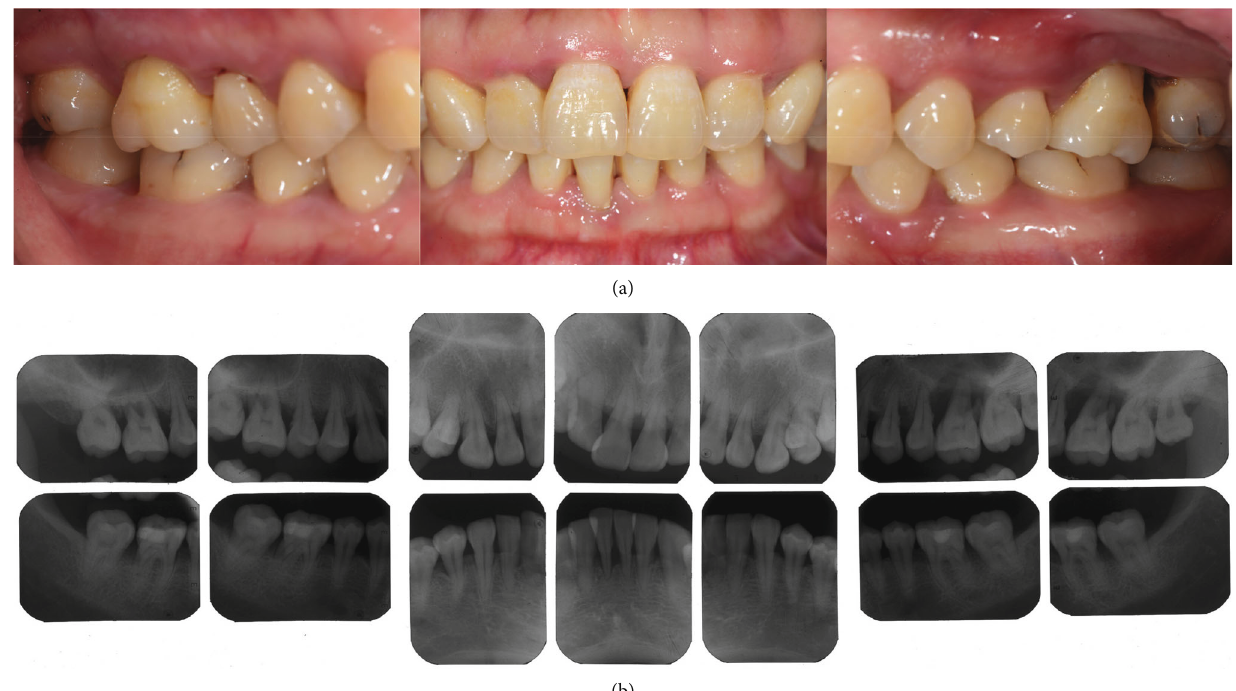
Figure 1: The patient had been diagnosed with aggressive periodontitis 4 years ago. Teeth #16 and #26 were severely compromised with bone loss to the apical third of root. (a) Intraoral photographs. (b) Periapical